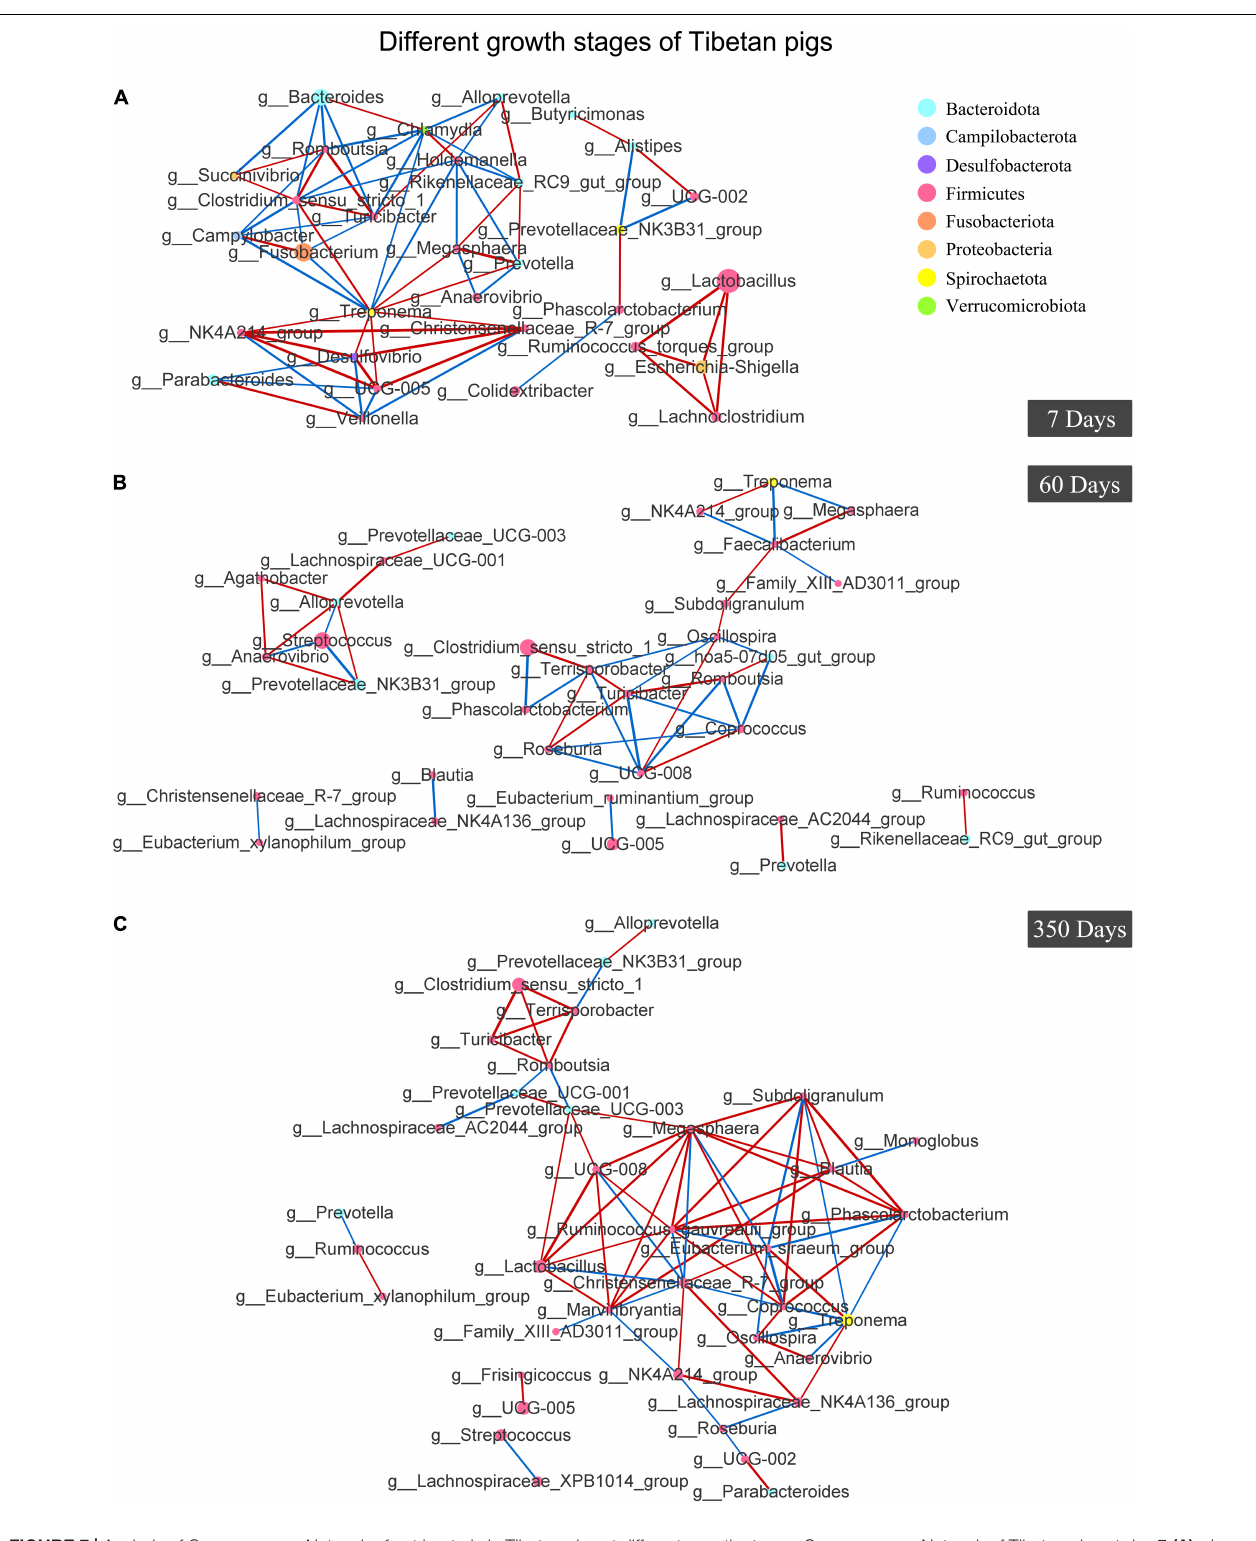
Frontiers in Microbiology |